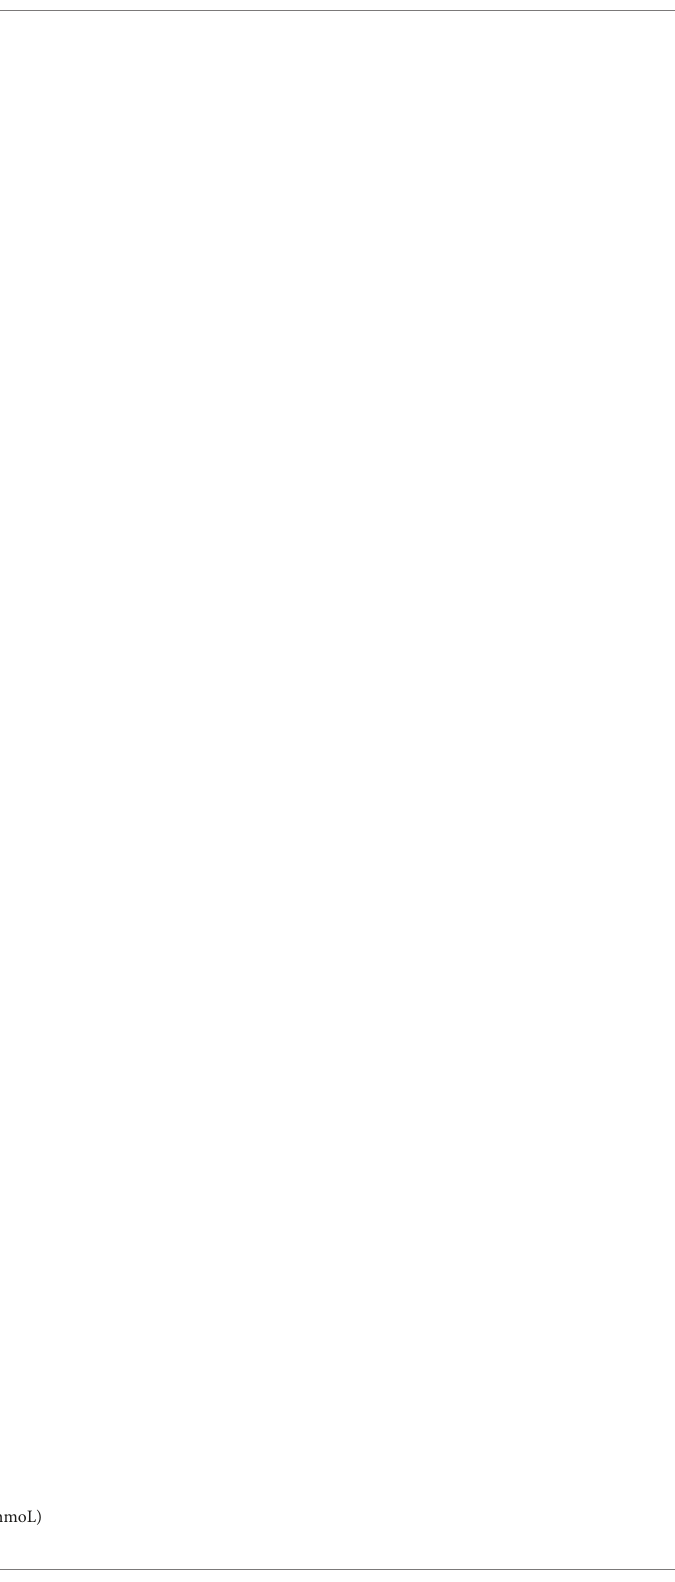
Patients with dementia ( N =